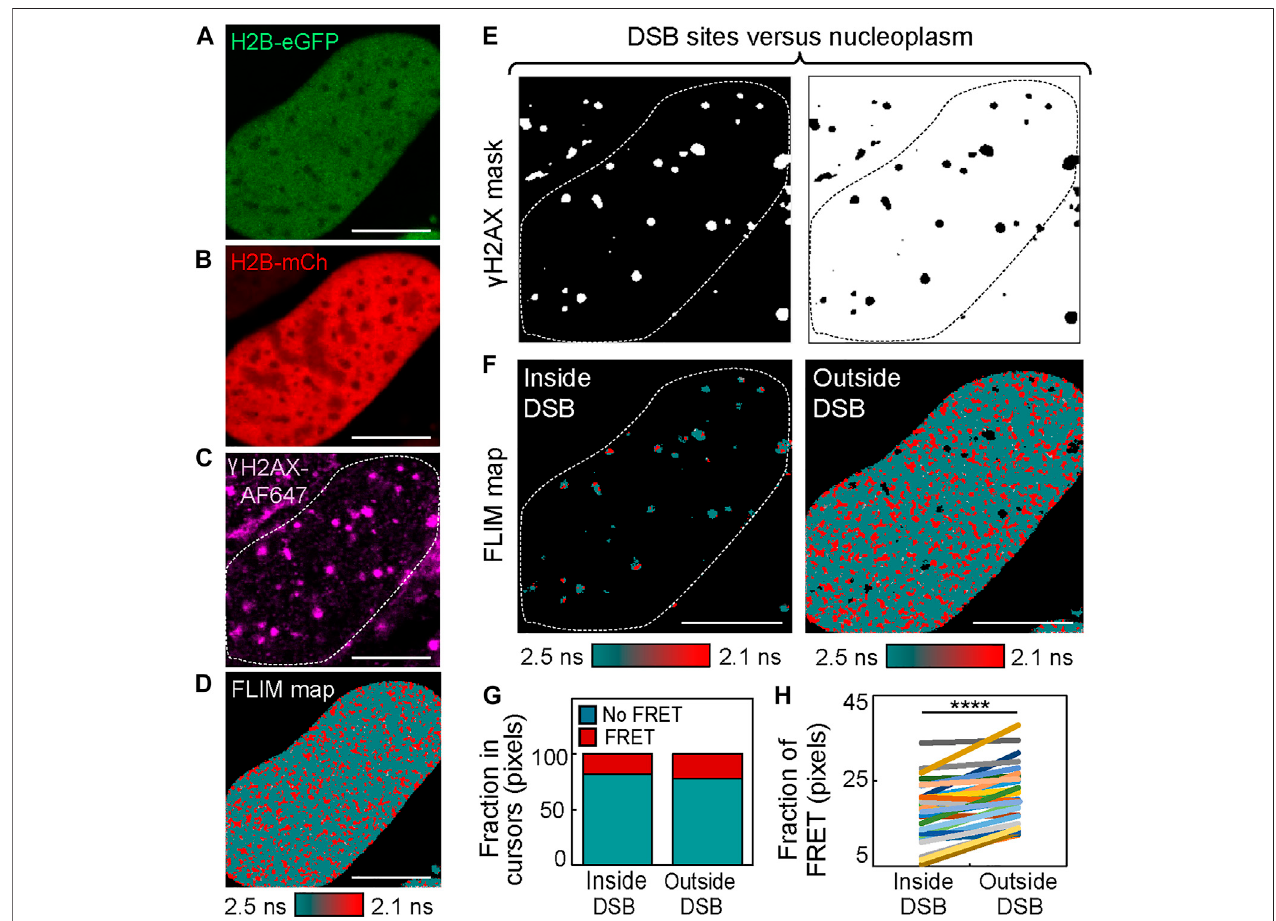
FIGURE2| IF-basedmaskanalysisofhistoneFRETintheDIvAcellsystemrevealschromatintobe “ open ” atsitesofDSBinduction. (A – C) DIvAnucleusco-expressingthe histone FRET pair H2B-eGFP (A) and H2B-mCh (B) that has been fi xed with IF against γ H2AX (C) after 2 h of treatment with 4OHT (scale bar 10 μ m). (D) FLIM map of the cell presented in panels (A – C) pseudo-colored to report histone FRET (red pixels) versus non-FRET (teal pixels). (E) Masks based on γ H2AX IF presented in panel (C) that select chromatininside (left) versusoutside (right) ofDIvADSBs. (F) Pseudo-coloredhistoneFRETmapswiththresholdde fi nedbymaskspresentedinpanel (E) appliedtoselect inside (left) versus outside (right) of DSBs. (G) Fraction ofpixels reportingFRET (compact chromatin) versusno FRET (open chromatin) within masked FLIM maps presented in panel (F) . (H) QuantitationofthefractionofhistoneFRET(compactchromatin)insideversusoutsideofDSBsafter2 hof4OHTtreatmentacrossmultiplecells(N (cid:1) 29cells,three biological replicates). The box and whisker plot shows the minimum, maximum, and sample median. **** p < 0.0001 (paired t